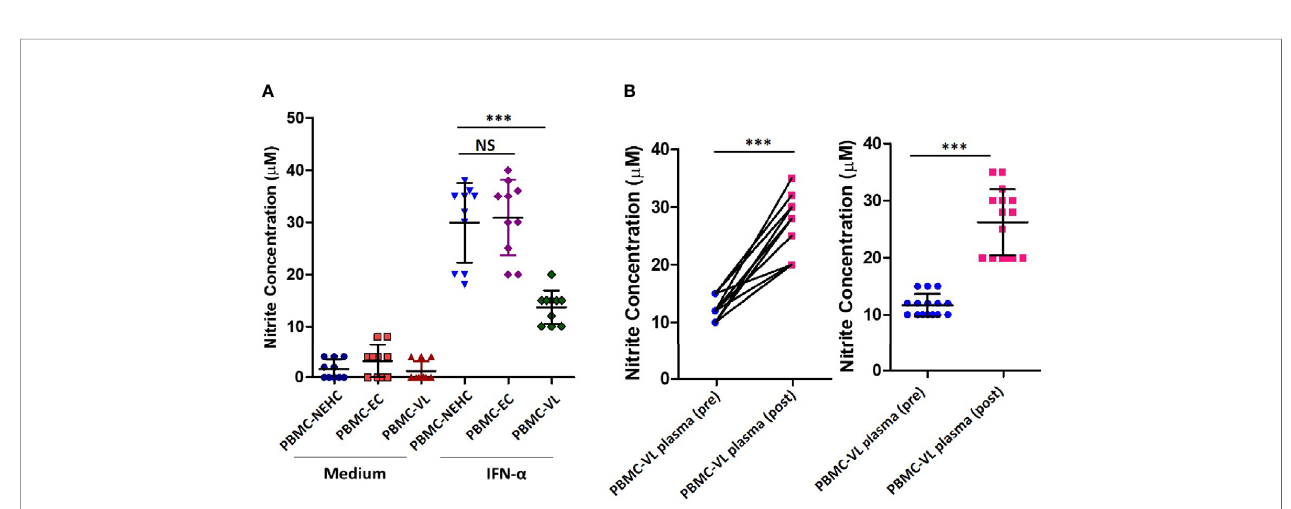
FIGURE 2 | PBMCs derived from VL patients show reduced IFN- a -responsiveness for NO production. (A) PBMCs were derived from the VL patients (n=10), ECs (n=10) and non-endemic healthy controls (n=10) were incubated with or without IFN- a in complete RPMI medium for 48 h. Nitrite concentrations were measured in the cell-free supernatant. (B) PBMCs derived from NEHCs were incubated with before treatment (n=15) or after treatment VL plasma (n=15) for 12 h and subsequently activated with IFN- a (500 U/ml) for 48 h. Nitrite levels were measured in the cell-free supernatant. Data in panels A and B were analyzed using two- tailed Mann-Whitney test and Wilcoxon signed rank test respectively; **p<0.01, ***p<0.001; NS, not signi fi cant; PBMC, peripheral blood mononuclear cell; VL, visceral leishmaniasis; EC, endemic control; NEHC, non-endemic healthy control.